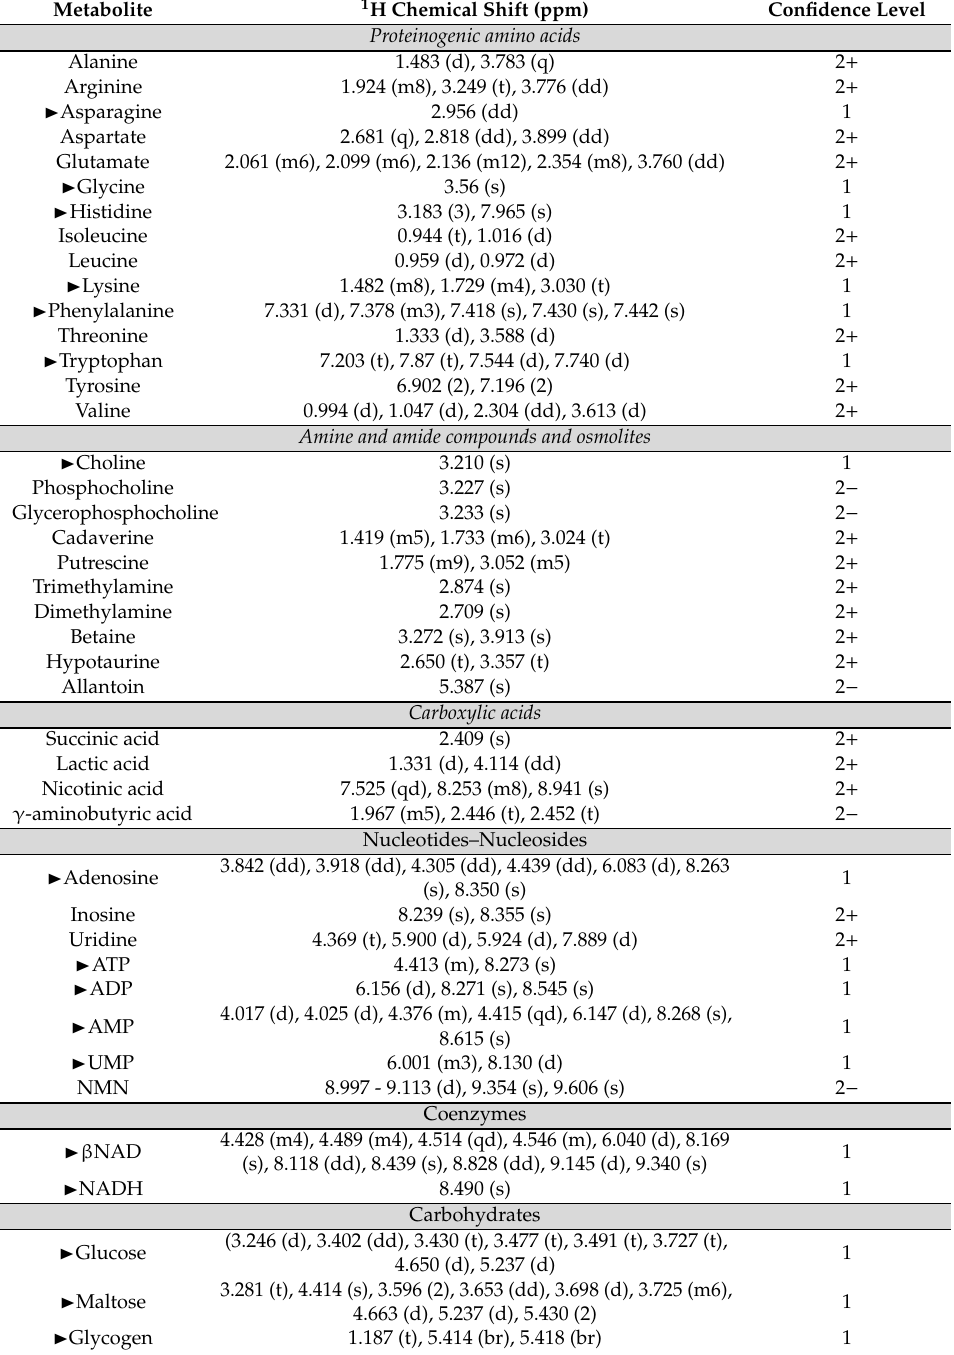
Table 1. List of metabolites identified in the 1 H NMR representative whole-body spectrum of Dreissena polymorpha , and their respective chemical shift and multiplicity (between brackets; s: singlet, d: doublet, t: triplet, q: quadruplet, dd: doublet of doublets, qd: quadruplet of doublets, m: multiplet, br: broad peak). If clearly identified on the J-resolved (JRES) spectrum, the number of peaks of a multiplet signal is specified. Number of identified peaks of the multiplet is given between brackets when the signal shape could not be confirmed by the JRES spectrum. Confidence levels: 1: assignment based on compound spiking in the sample; 2 + : assignment based on a reference spectrum from a database, with several confirmations from 2D NMR experiments. 2 − : assignment based on a reference spectrum from a database, with only one confirmation from 2D NMR experiments, or corresponding to poorly referenced spectra in